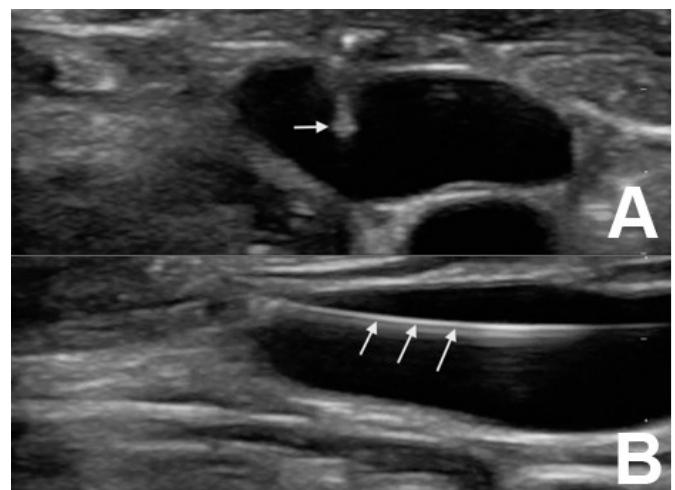
Figure 2. A) Cross-sectional view of the left internal jugular vein with needle in lumen. B) Longitudinal view of guidewire in lumen of left internal jugular